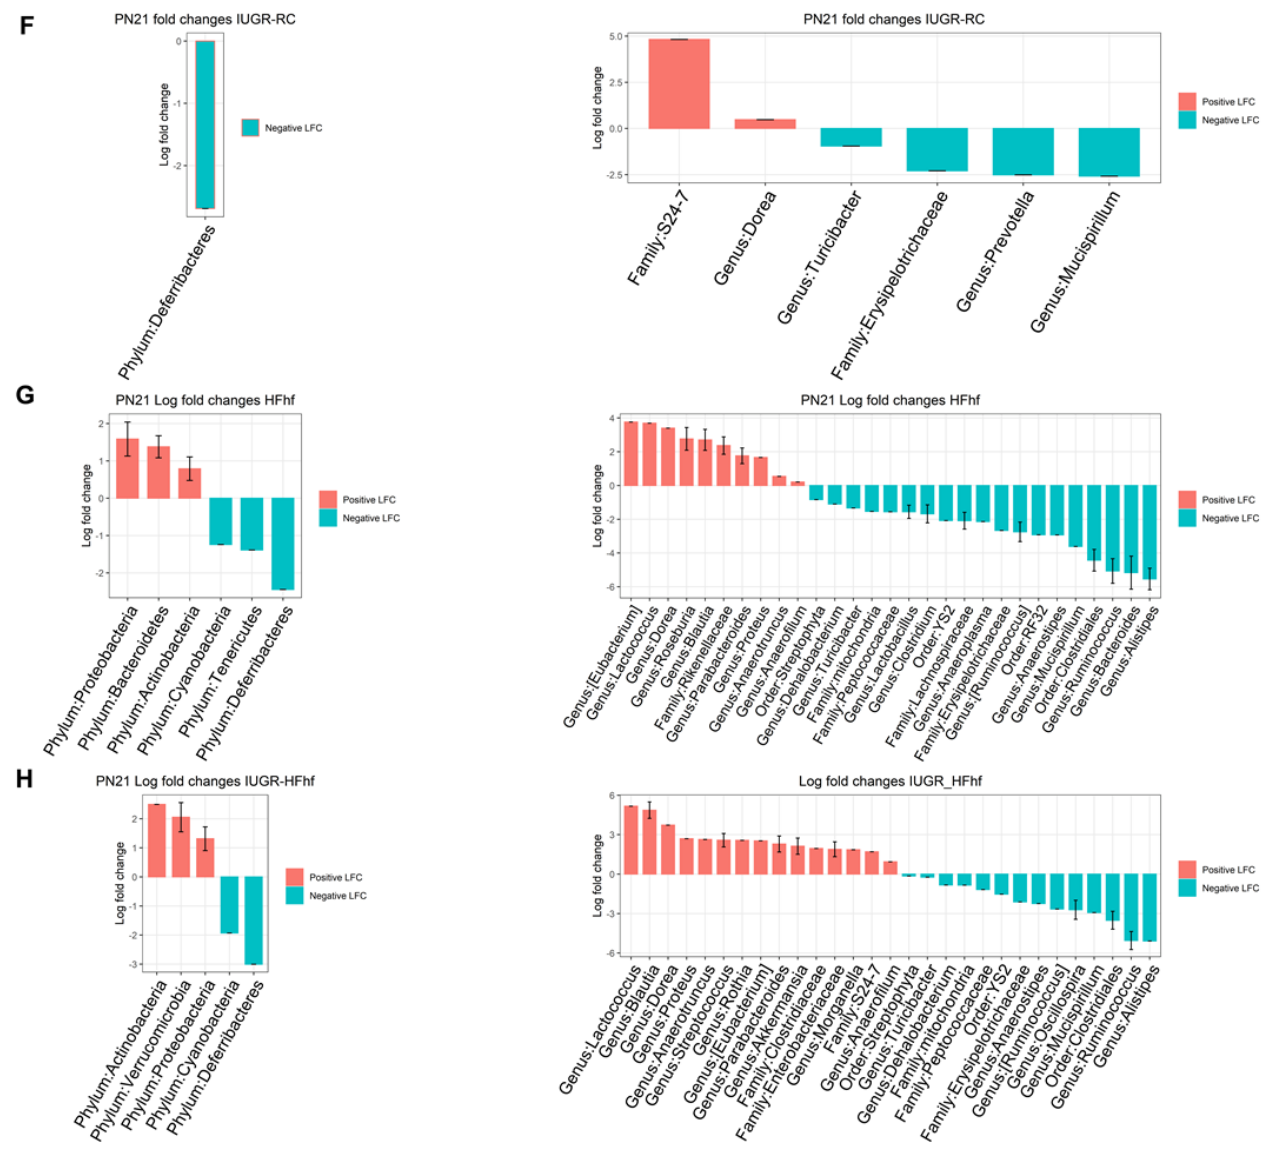
Figure 5. Violin plots showing gut microbiota alpha diversity at postnatal day 21 (PN21) ( A – D ) with four different matrices. Kruskal–Wallis p -values are denoted for each comparison with post hoc Dunn test for comparison between different dietary groups. Significance levels are marked as * p < 0.05, *** p < 0.001, **** p < 0.0001. n.s., not statistically significant. ( E ) Principal coordinates analysis